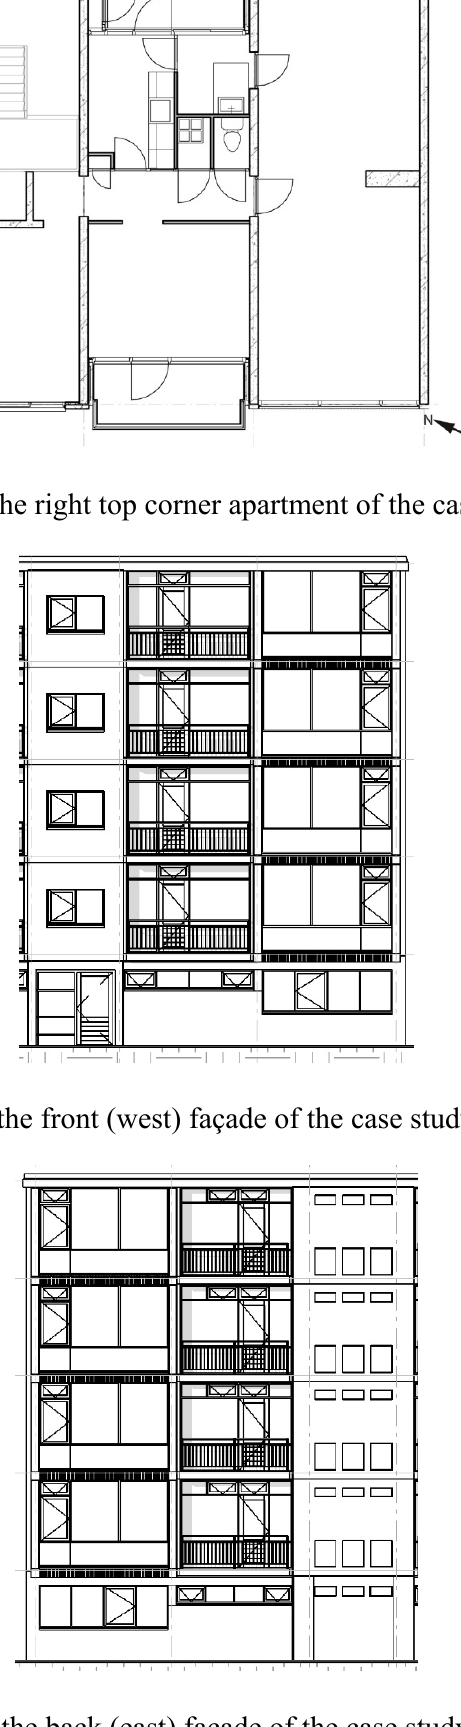
Figure 6. Part of the back (east) façade of the case study building